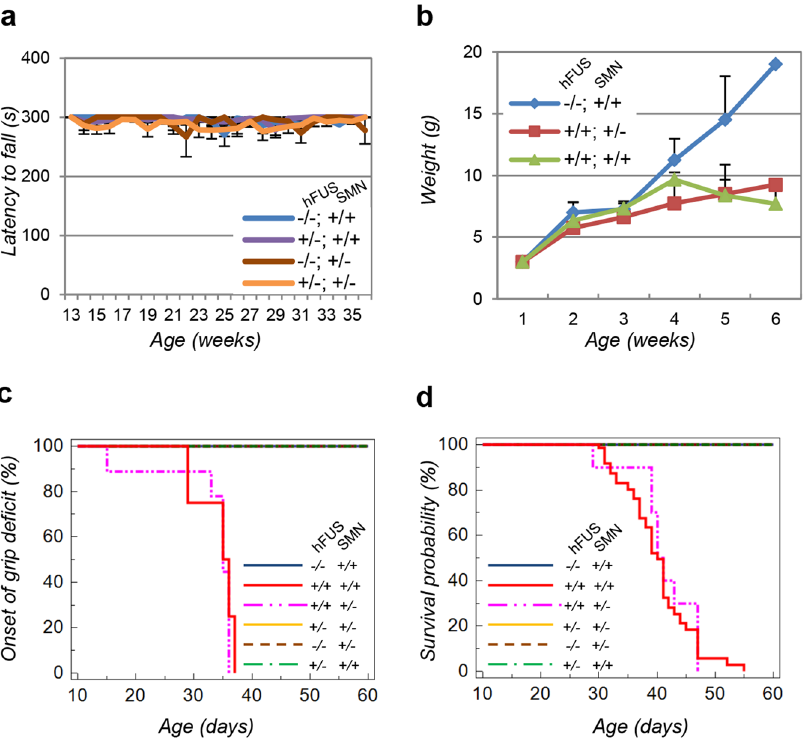
Figure 5. Disease progression in hFUS + / + mice is not influenced by SMN depletion. ( a ) The indicated mice were subjected to a Rotarod analysis once a week starting from 13 weeks and for the following 23 weeks. At least 15 animals for each genotype were used. Results were plotted as mean ± SE. ( b ) Mice with the indicated genotypes were weighted weekly starting from 1 week of age. Approximately 5 animals for each genotype were monitored. The average weight ± SD is shown. ( c ) Mice were subjected to grip test analysis for the indicated time frame. The age (days) when animals failed the test were considered the onset of grip deficits and analysed with Kaplan-Meier analysis. Statistical analysis reveals an average onset of grip deficits at 35 ± 4 days for hFUS + / + ; Smn + / + mice and at 35 ± 3 days for hFUS + / + ; Smn + / − mice. ( d ) Kaplan-Meier analysis of cumulative survival of mice with the indicated genotypes. Log–rank test was used to compare hFUS + / + ; Smn + / − and hFUS + / + ; Smn + / + animals. At least 30 animals for each genotype were scored, except for the hFUS + / + ; Smn + / − , where 17 animals were used. Statistical analysis of cumulative survival reveals an average survival time of 40.2 ± 5.8 days for hFUS + / + ; Smn + / + mice and 40.6 ± 5.3 days for hFUS + / + ; Smn + / −